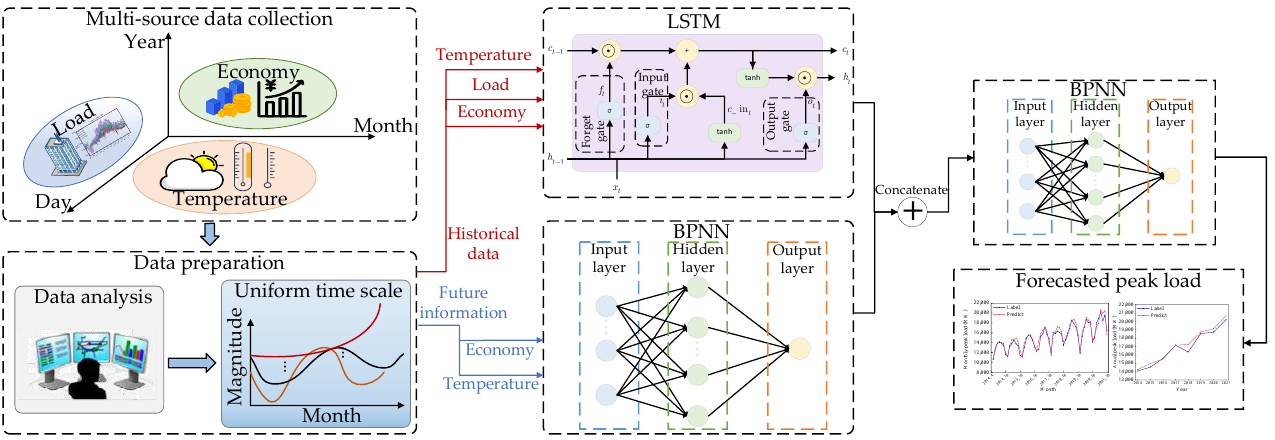
Figure 6. Structure of the hybrid LSTM – BPNN-to-BPNN peak load forecast model.